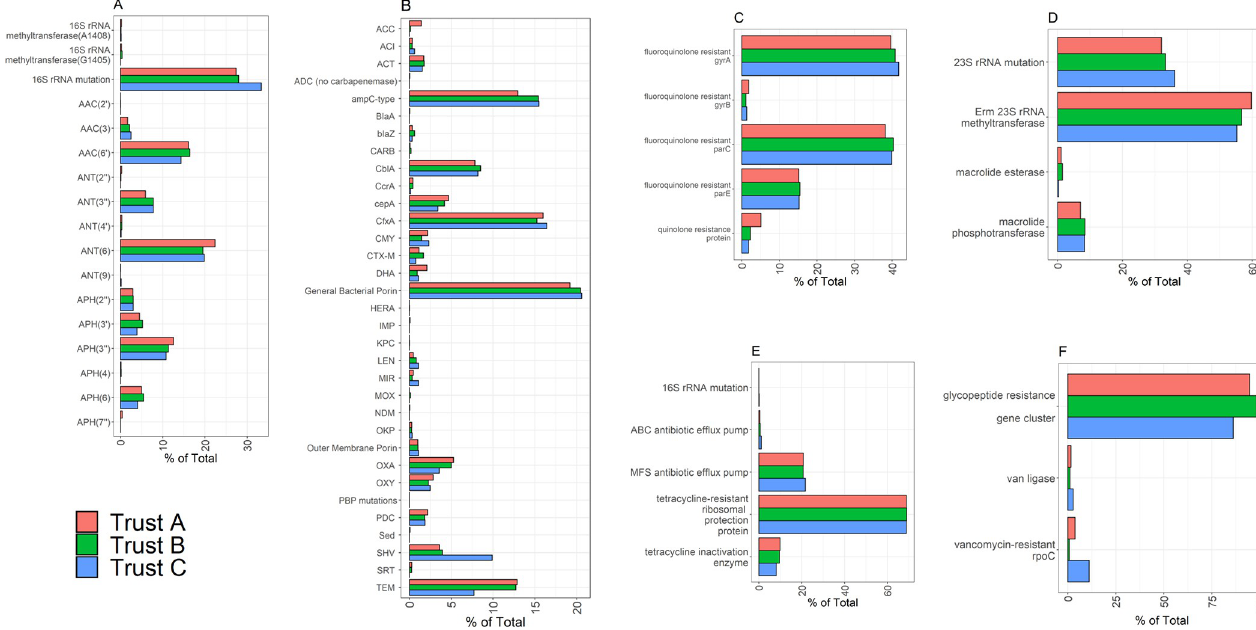
Fig 4. AMR gene frequency. Graphs show the contribution of different molecular mechanisms of resistance for each antibiotic class. A) aminoglycosides B) beta-lactams C) quinolones, D) macrolides, E) tetracyclines, F)